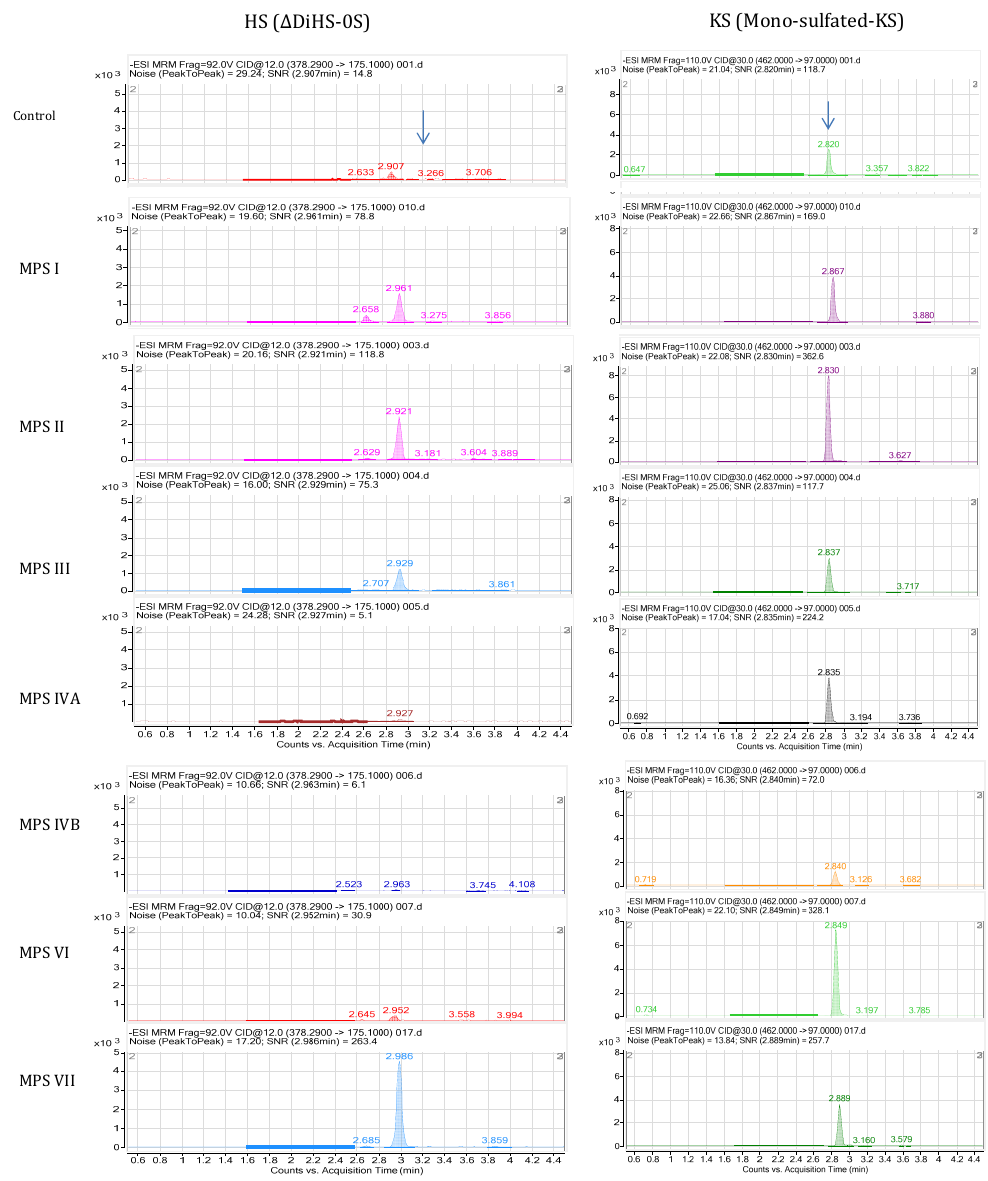
Figure 2. MRM of LC-MS/MS for plasma or serum samples in patients with MPS I-VII. Δ DiHS-0S ( left ) and mono-sulfated KS ( right ) are